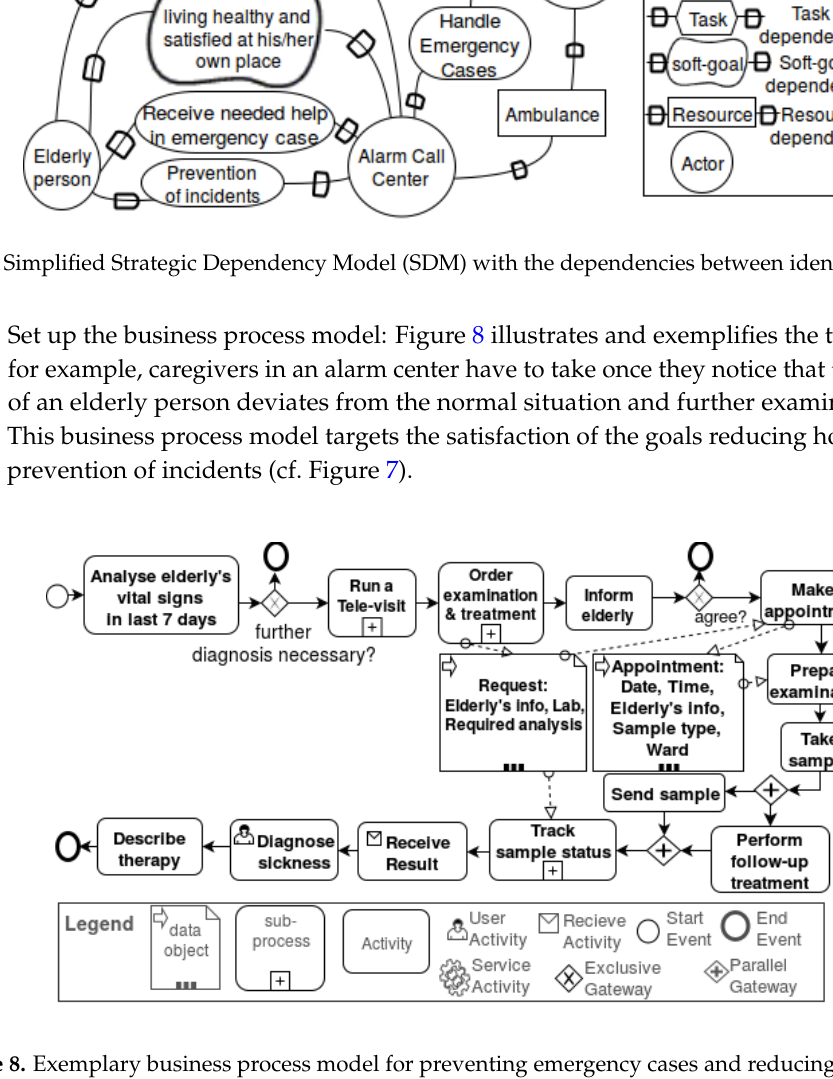
Figure 8. Exemplary business process model for preventing emergency cases and reducing hospital